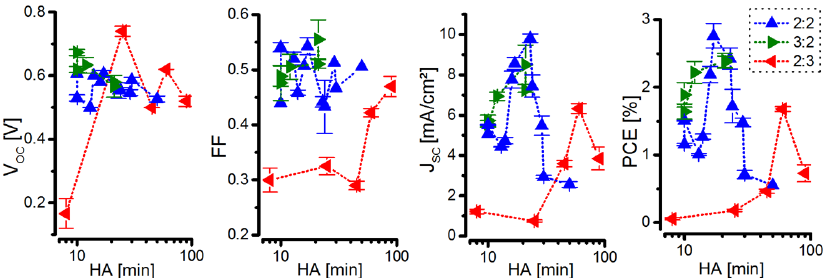
Figure 5. Dependency of open-circuit voltage ( V OC ), fill factor (FF), short-circuit current density ( J SC ) and PCE on the HA washing time at 105 °C for hybrid BHJ solar cells containing CdSe NCs taken from the respective PL brightpoint of the NC hot-injection syntheses performed at 300 °C with a 100:3:2, 100:2:2, and 100:2:3 ratio of (HDA/TOPO):(Cd-SA):(TOP-Se). The results are obtained from two synthesis batches for each ratio and from 60 solar cells, which were thermally post-annealed until reaching their optimal performance.